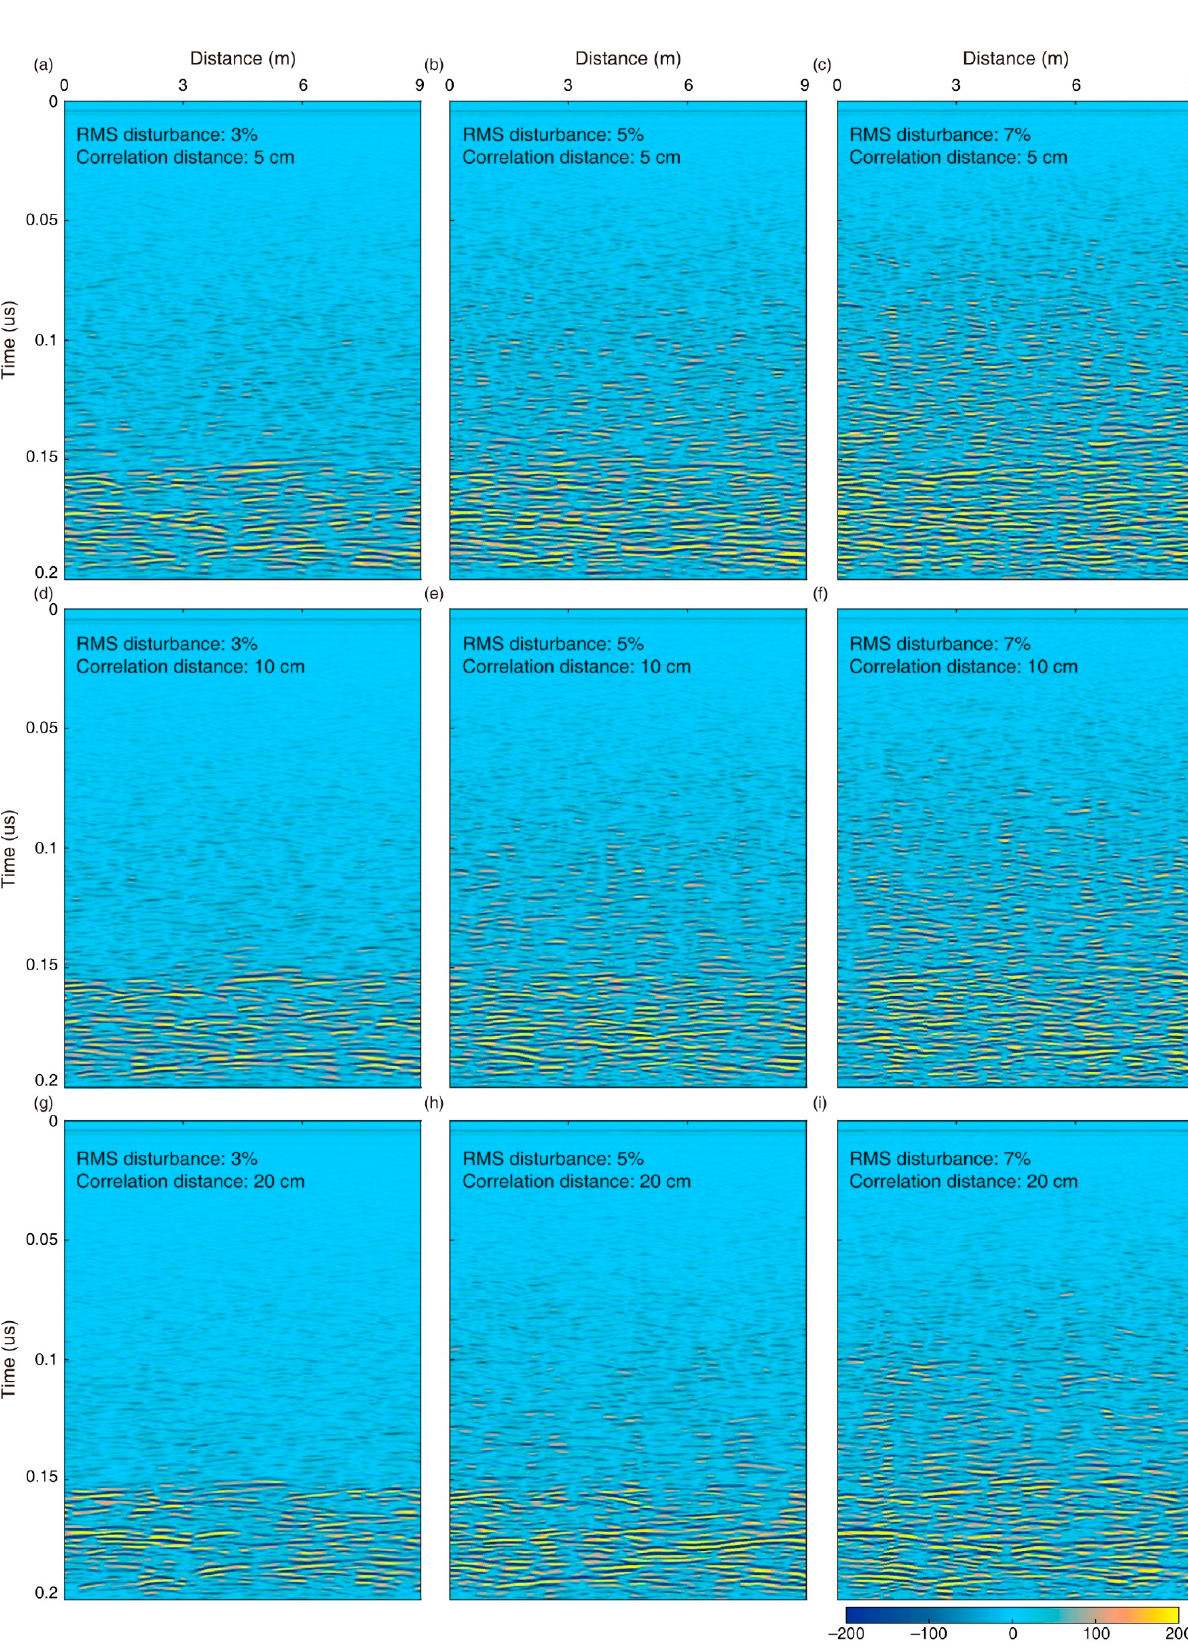
Figure 6. Numerical simulation results using different parameters. The three columns from left to right are with RMS perturbation of 3%, 5%, and 7%, respectively. The three rows from top to bottom are with correlation distance of 5, 10, and 20 cm,